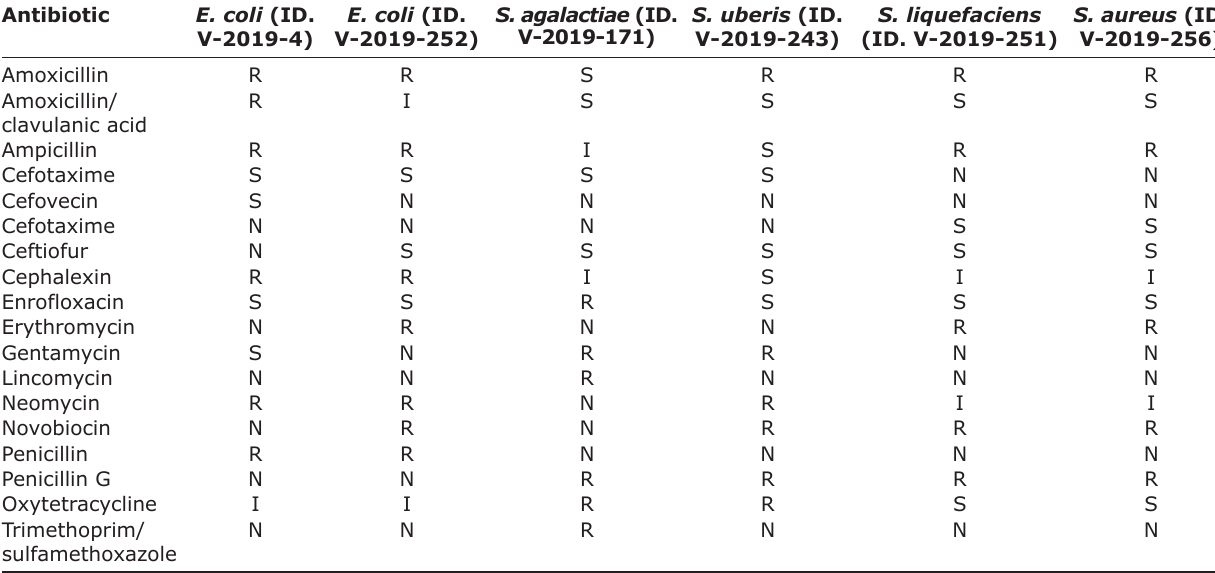
Table-1: Characteristics of clinical isolates of bovine mastitis.